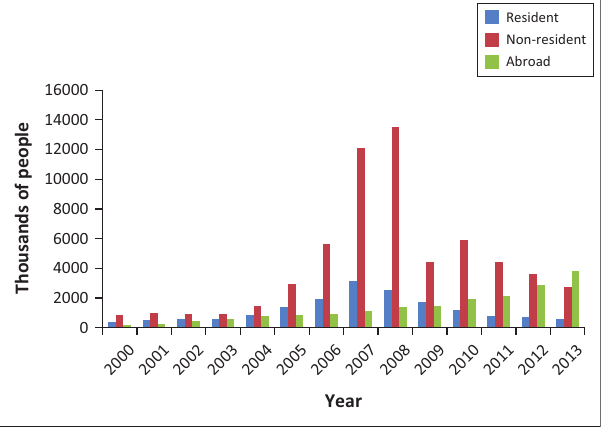
FIGURE 4: Patent grants by source for Russia (thousands of people).